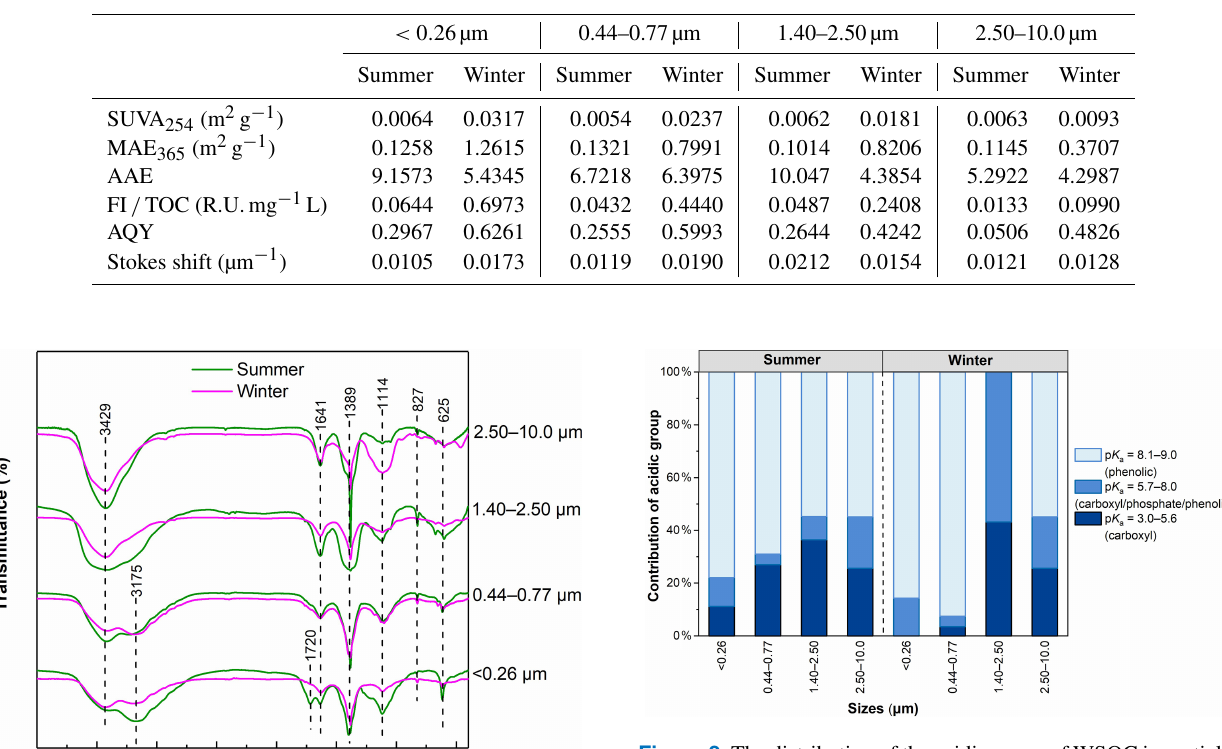
Figure 2. The distribution of the acidic group of WSOC in particles of different sizes in summer and